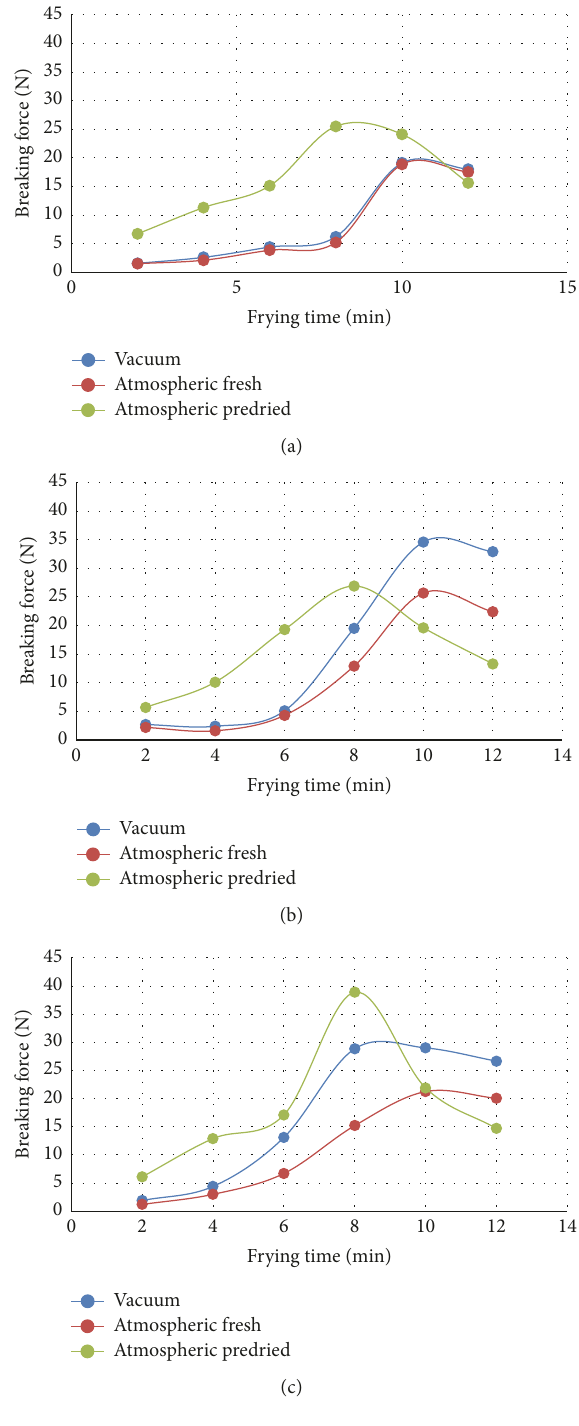
Figure 1: Effect of frying conditions on breaking force (N) of yellow fleshed cassava chips (YFCC) at different equivalent thermal driving forces (ETDF) of (a) 60 ∘ C, (b) 70 ∘ C, and (c) 80 ∘